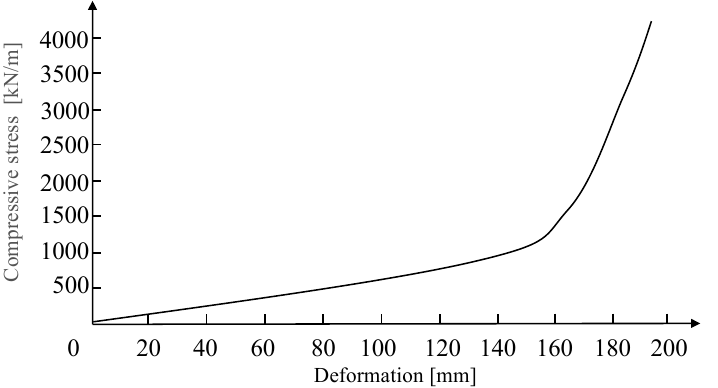
Figure 14. The compressive stress–deformation curve of the GINA gasket (redrawn according to Lin and Liu [42]).